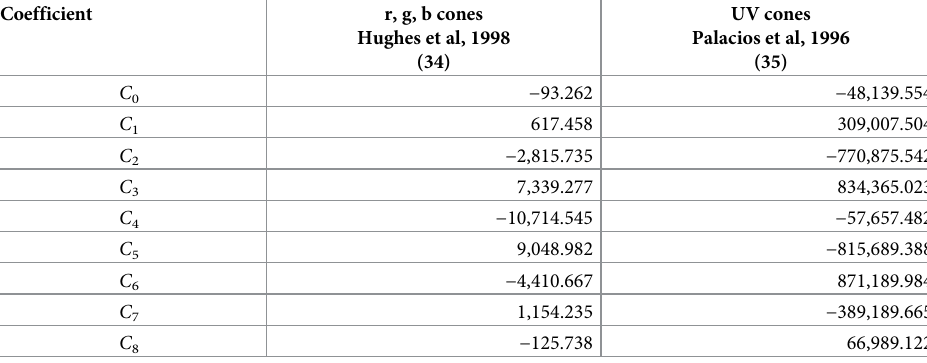
Table 6. Polynomial coefficients for cone opsin absorbance